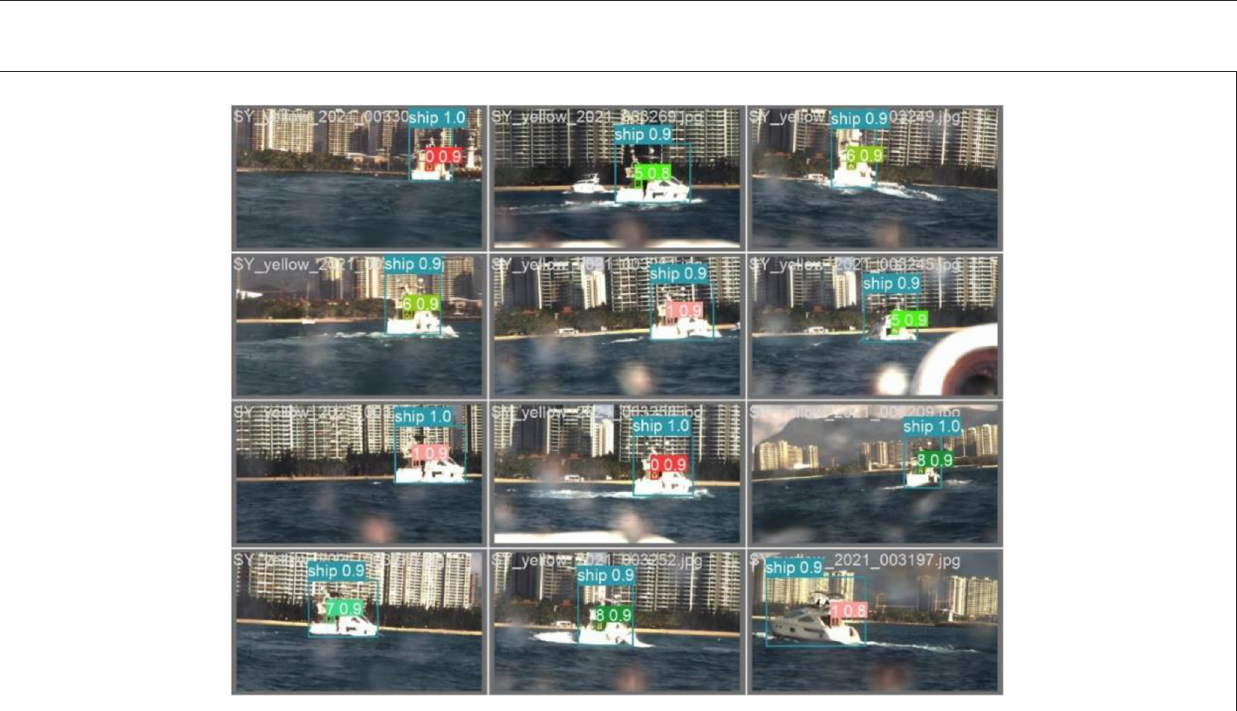
FIGURE11 The samples of recognition